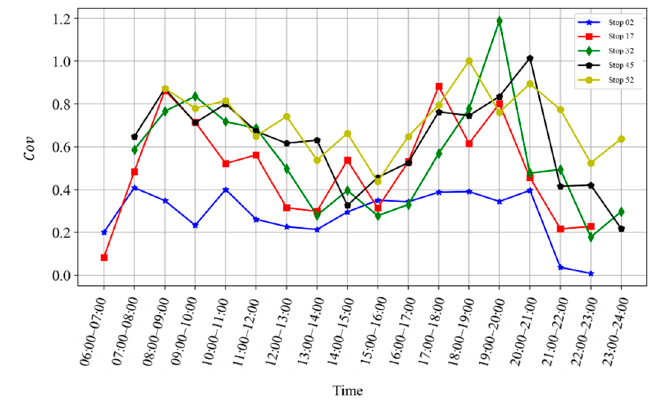
Figure 7. Daily variation of Cov .